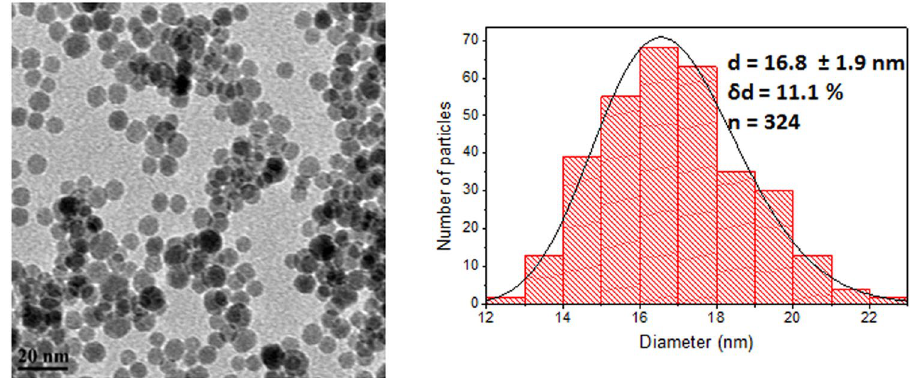
Figure 1. TEM images and particle size distributions of iron oxide nanoparticles synthesized. Magnification 25 k scale bar 20 nm. Size distributions were fitted with a log normal function (solid line), d = mean diameter, δ d = standard deviation and n = number of particles